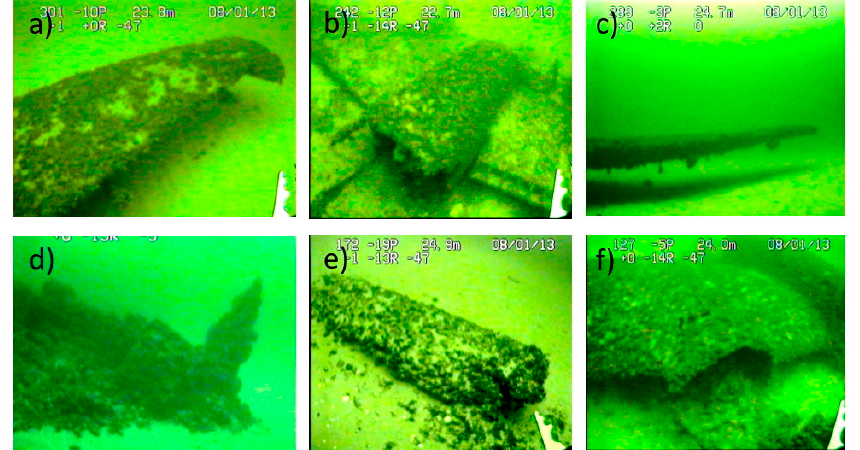
Figure 10. Video data recorded with the ROV camera: ( a ) part of the right wing; ( b ) part of the cockpit; ( c ) part of the left wing; ( d ) engine propeller; ( e ) part of the tail detached; ( f ) engine cover on the right wing.